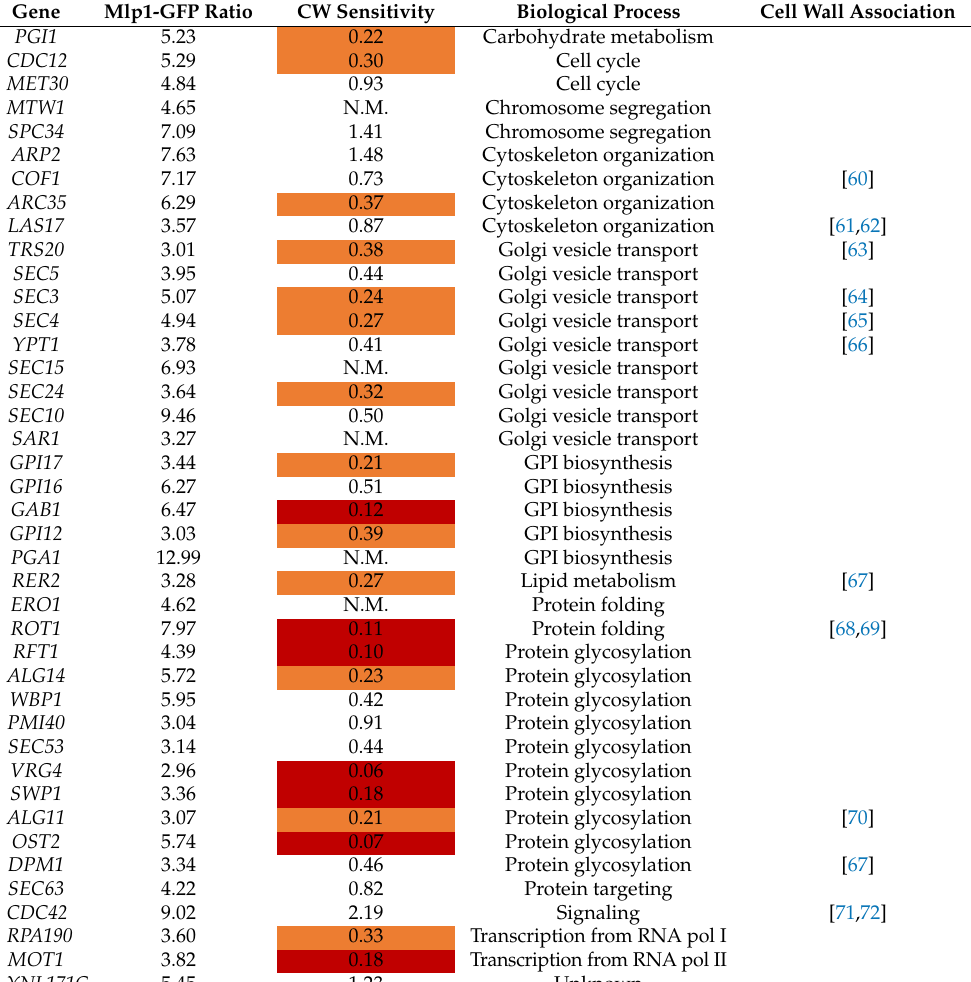
Table 2. List of genes corresponding to those mutants showing increased Mlp1-GFP levels under non-stress conditions. Mlp1-GFP ratio refers to the MFI (mean fluorescence intensity) value for each mutant respect to the wild-type. CW sensitivity denotes the sensitivity level to CW obtained from the phenotypic screen previously described. Those mutants with ratio ≤ 0.2 are highlighted in red and those with ratio ≤ 0.4 in orange. N.M.: non-measurable. References including previously described cell wall associations are